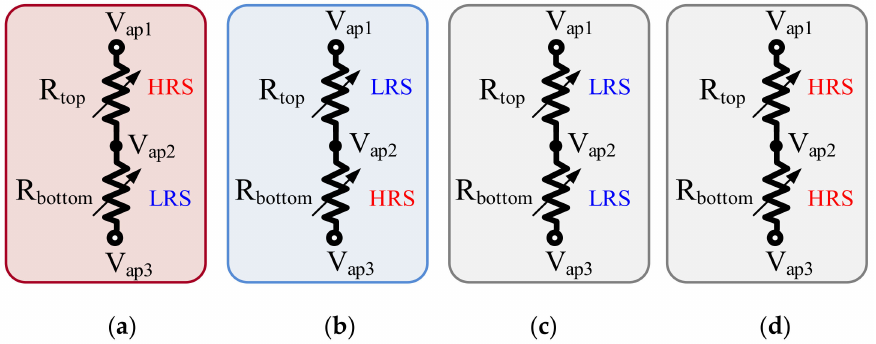
Figure 4. Data stored in the serial cell depends on the resistance state of the RRAMs: ( a ) ‘0’; ( b ) ‘1’; ( c ) Masked in the LRS; ( d ) Masked in the HRS.